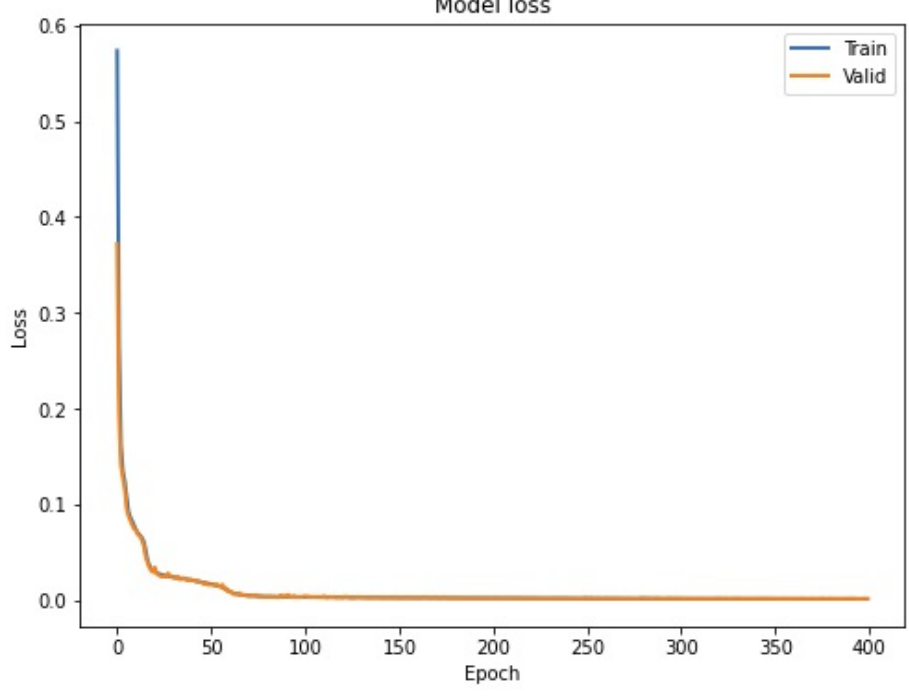
Figure 24. Model loss during the training and validation time.